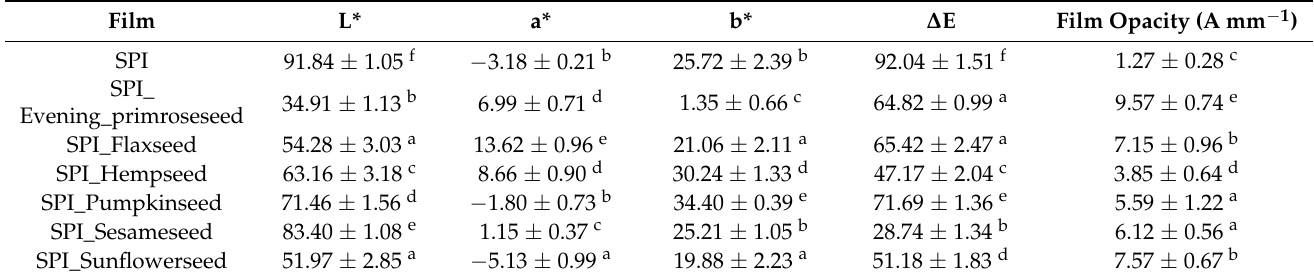
Table 2. Color attributes (L*, a*, b*) and total color difference ( ∆ E) of soy protein isolate–oilseed flour